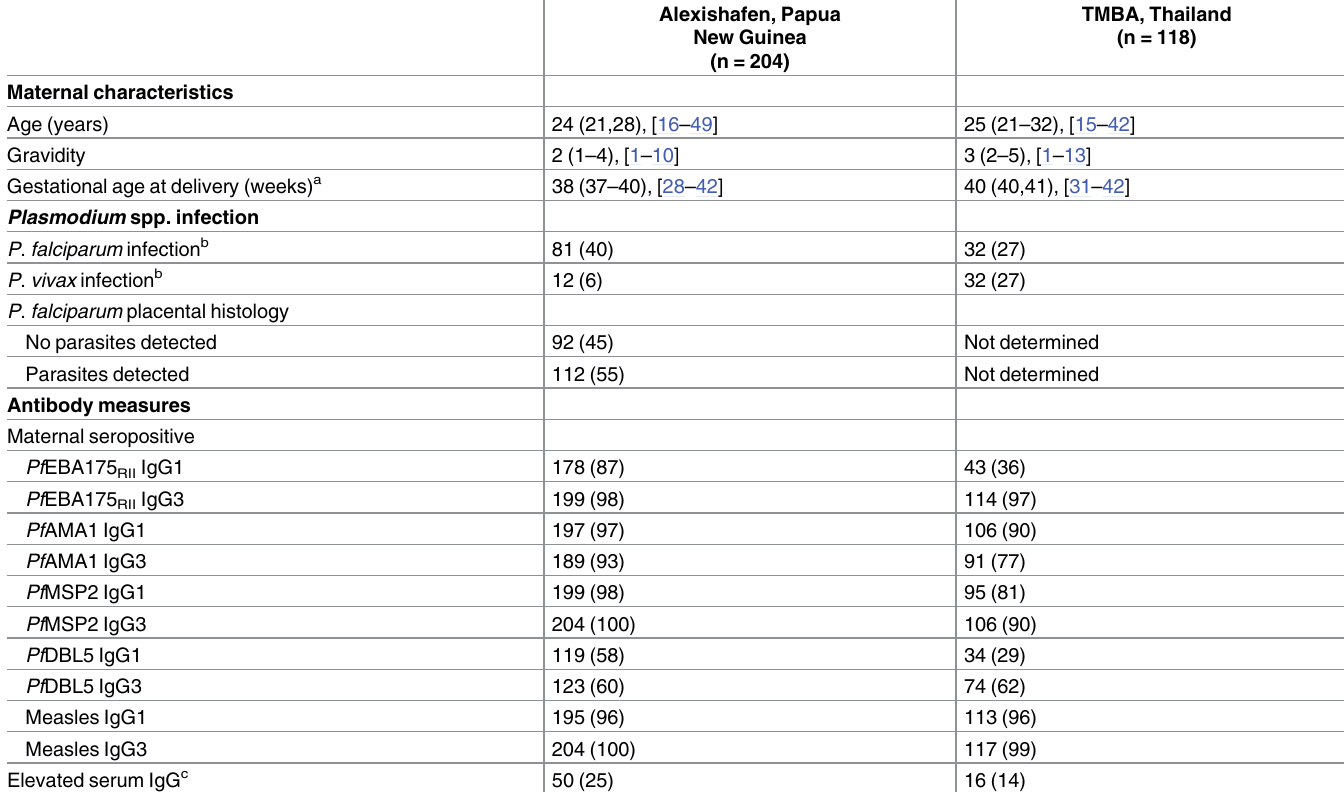
Table 1. Distribution of maternal characteristics by study